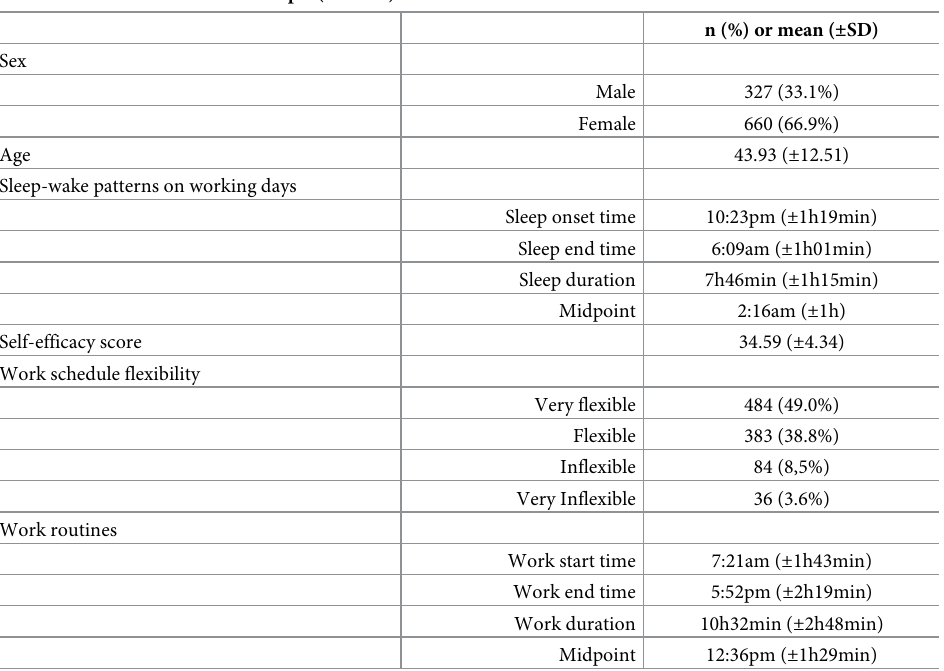
Table 1. Characteristics of the sample (N =